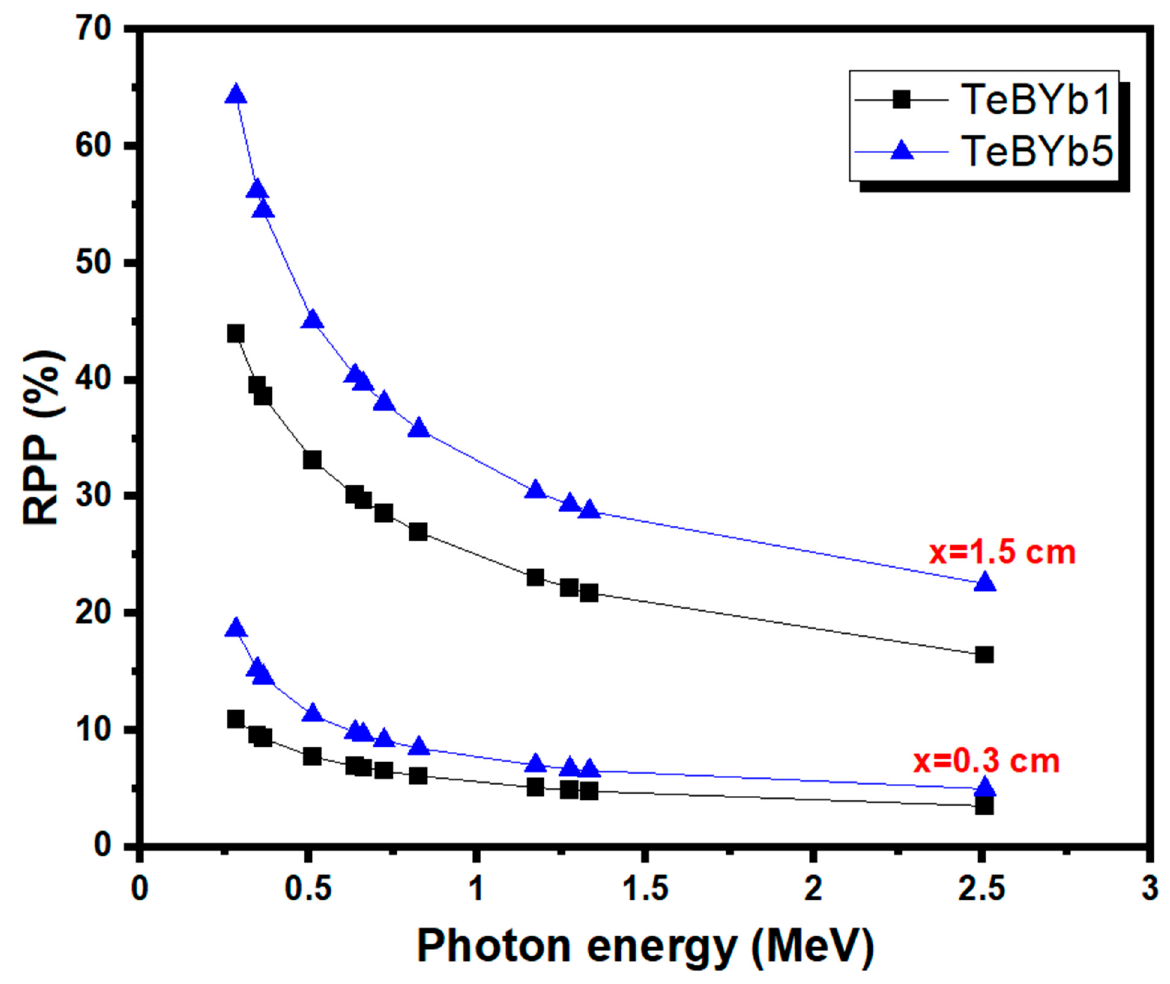
Figure 6. The radiation protection efficiency for TeBYb1 and TeBYb5 as a function of the energy at 0.3 and 1.5